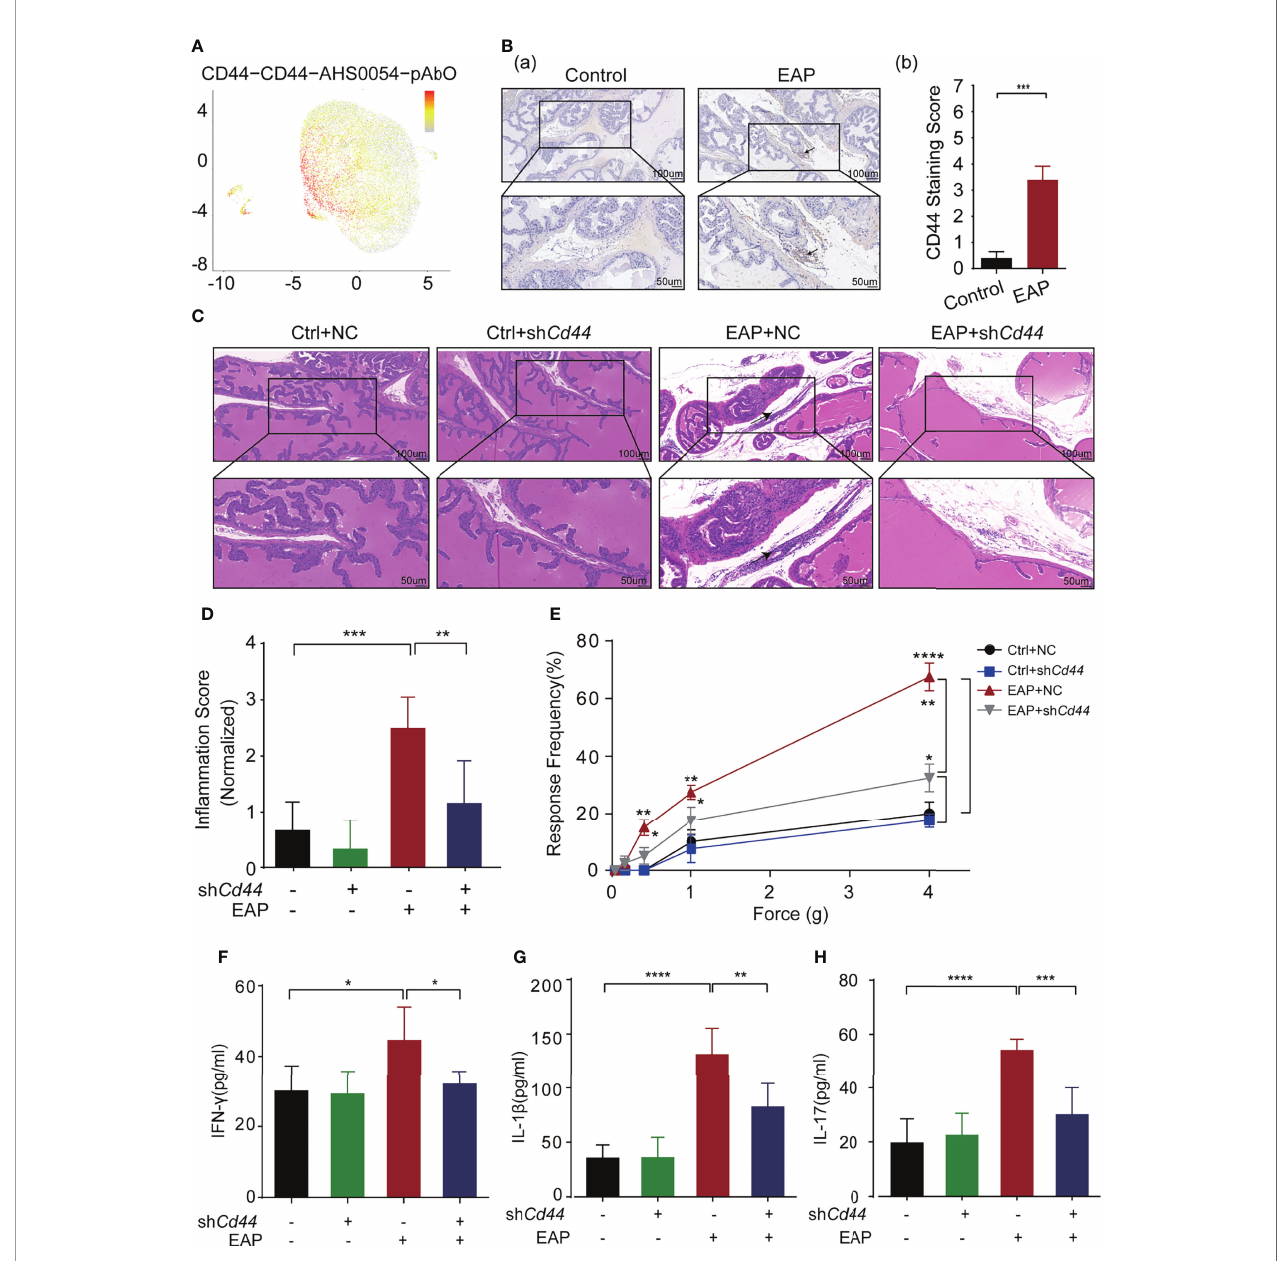
FIGURE 1 | Identi fi cation and validation of key molecule-CD44 for CP/CPPS. (A) Single-cell gene sequencing showed that CD44 + T cells accounted for more than 93% of the total T lymphocytes. (B) The expression of CD44 in prostate tissues of mice between control and EAP groups. (C) Analysis of histological difference by HE staining. (D) Corresponding histopathological score and data analysis according to data in Panel (C) . (E) Tactile allodynia development in NOD mice from those four groups. (F) The secretion levels of IFN- g in serum of NOD mice from those four groups. (G) The secretion levels of IL-1 b in serum of NOD mice from those four groups. (H) The secretion levels of IL-17 in serum of NOD mice from those four groups. ****p < 0.0001, ***p < 0.001, **p < 0.01, *p <